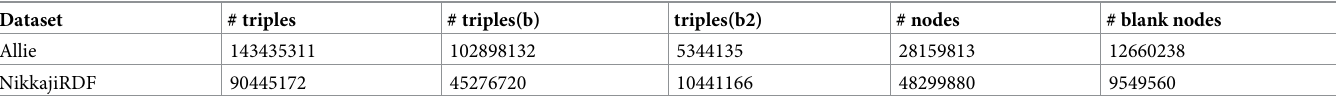
Table 1. Features of Allie and NikkajiRDF